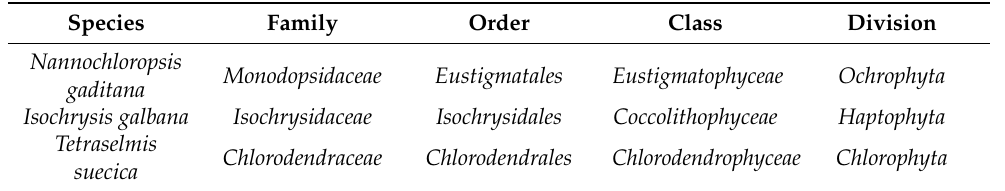
Table 2. Characteristics of each of the phytoplankton species. Species Size Shape Nannochloropsis gaditana 3–5 µ m spherical fucoxanthin Isochrysis galbana 6–12 µ m ellipsoid Tetraselmis suecica 10–15 µ m oval